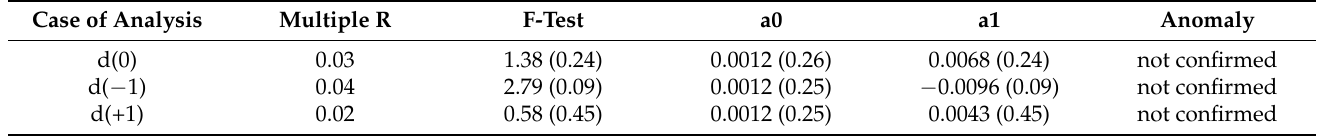
Table A6. Regression analysis with dummy variables: results of the expiration day price effects